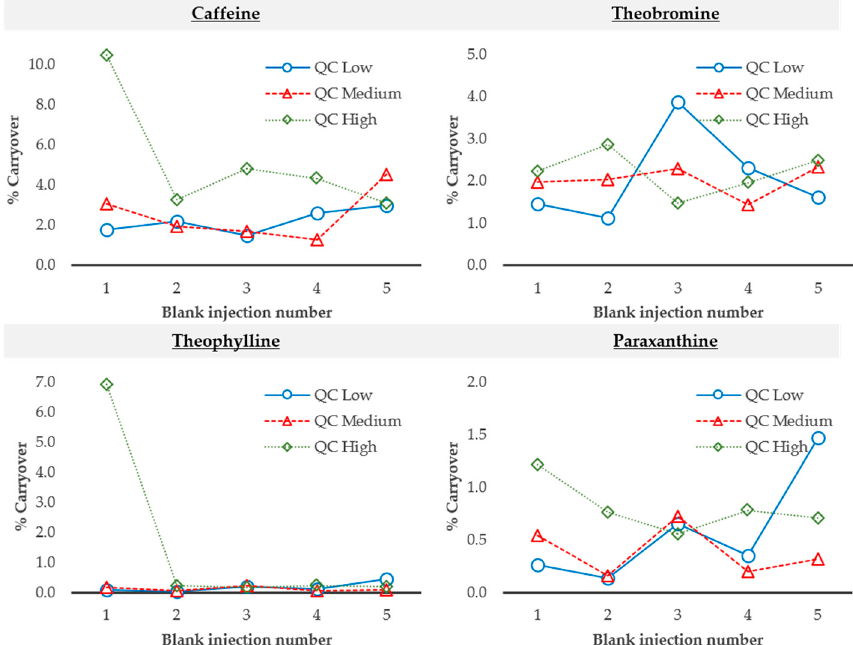
Figure 5. Carryover results for caffeine, theobromine, theophylline, and paraxanthine. After the injection of each concentration level of the quality controls, five blank solvent samples were analyzed and peak areas were divided by the peak area obtained for the LOQ. The graphs show the percentage of this ratio for each one of the five injections and considering each analyte. QC—quality control. Table 4. Ca ff eine, theobromine, theophylline and paraxanthine quantification by LC-MS / MS in plasma human